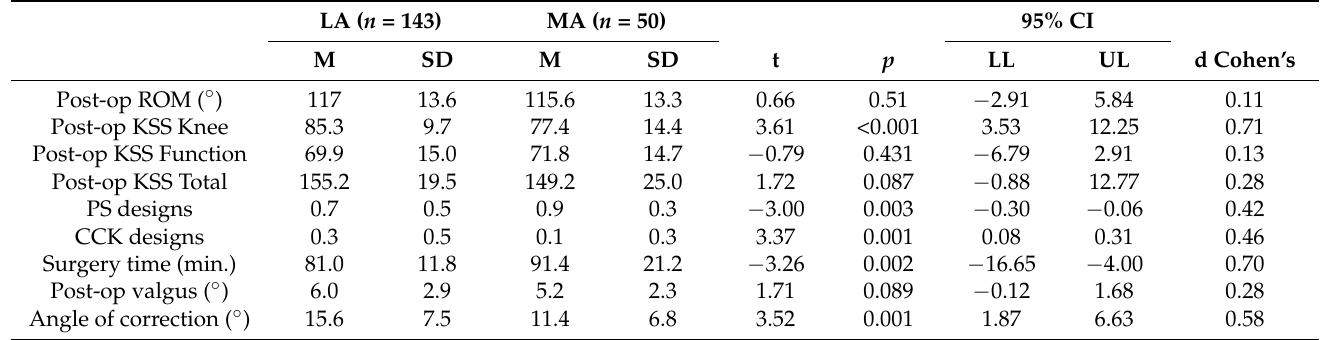
Table 3. Comparison of postoperative variables in medial and lateral approaches.